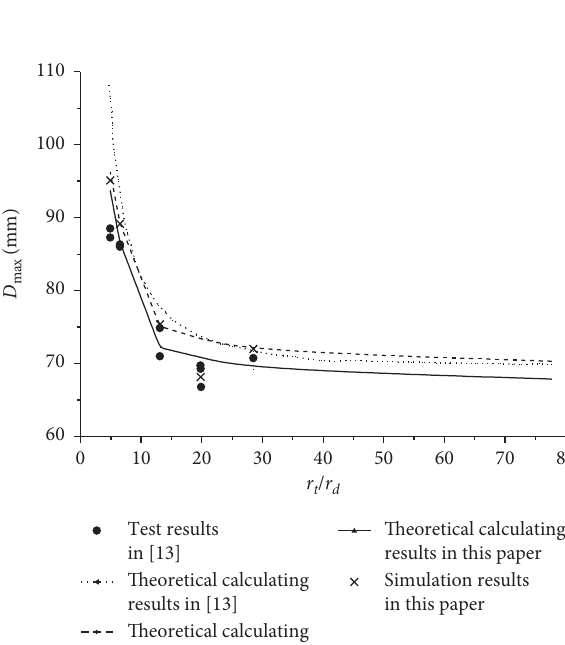
Figure 3: Comparison of the penetration depth.